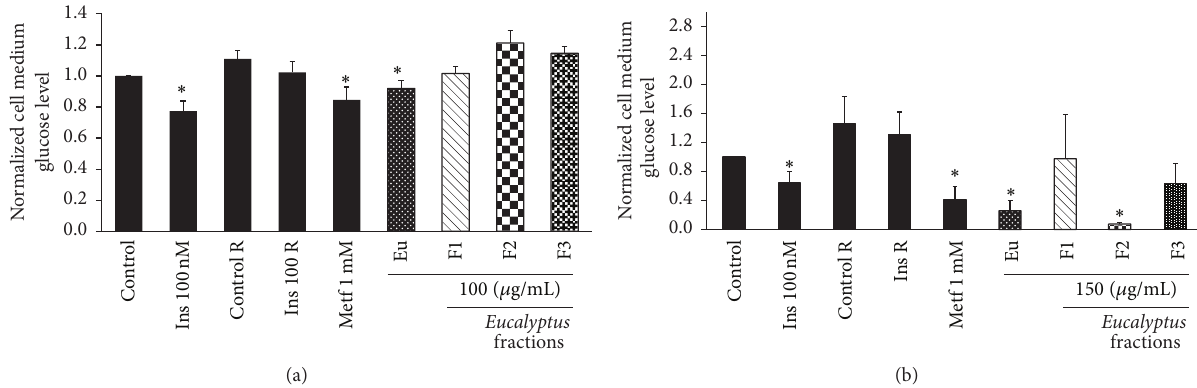
Figure 1: Effect of raw extract and fractions from E. tereticornis on insulin-resistant C2C12 and HepG2 cells. Glucose uptake in insulin- resistant C2C12 cells (a) and glucose production in insulin-resistant HepG2 cells (b). Cells were treated with different concentrations of the fractions or raw extract and glucose was measured in cultured supernatant after 4h of treatment by the glucose oxidase technique. Eu, crude methanol extract; Ins (100nM insulin); Control R, insulin-resistant C2C12 myotubes as controls; Ins 100 R, insulin-resistant C2C12 myotubes treated with 100nM insulin; Metf, metformin 1mM positive control. Bar values correspond to the arithmetic mean of glucose concentration for each treatment/control glucose concentration, 𝑛 = 6 (C2C12) and 𝑛 = 3 (HepG2). ∗ Ins 100 nM versus control. ∗ Treatment versus control R. 𝑝 < 0.05 , Student t -test. Error bars represent